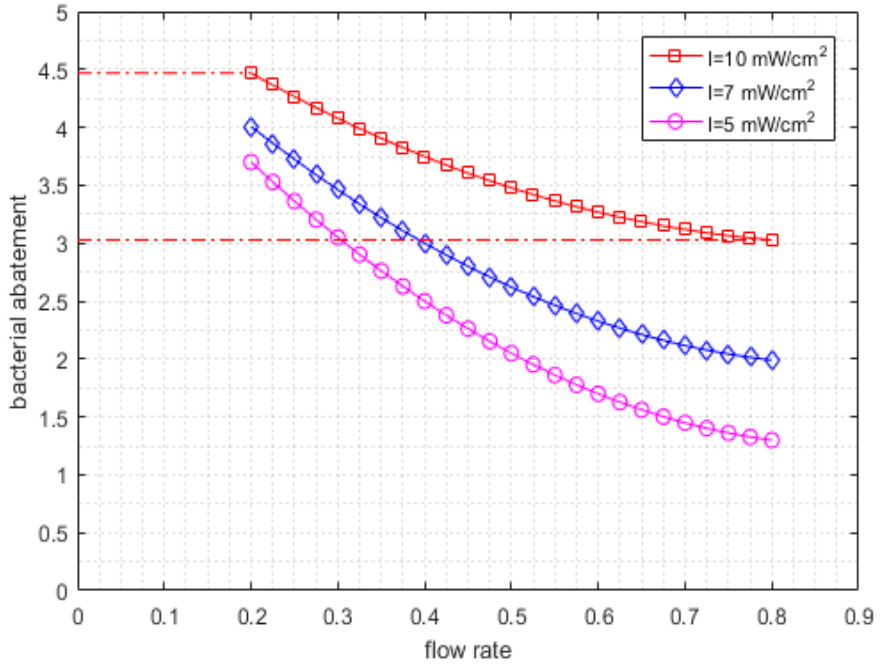
Figure 4. Static gains generation using procedure A ( I 0 , Q 0 , t ). Figure 4 confirms the physical behavior of the UVDS: the bacterial abatement dimin- ishes with the increase in the flow rate and increases with the increase in the UV